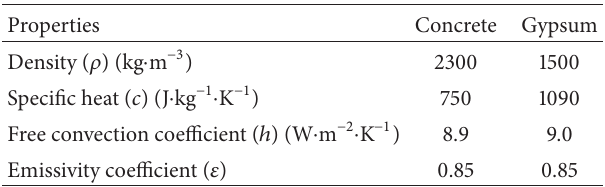
Table 2: Physical properties of the materials at 25 ∘ C and 1atm. Properties Concrete